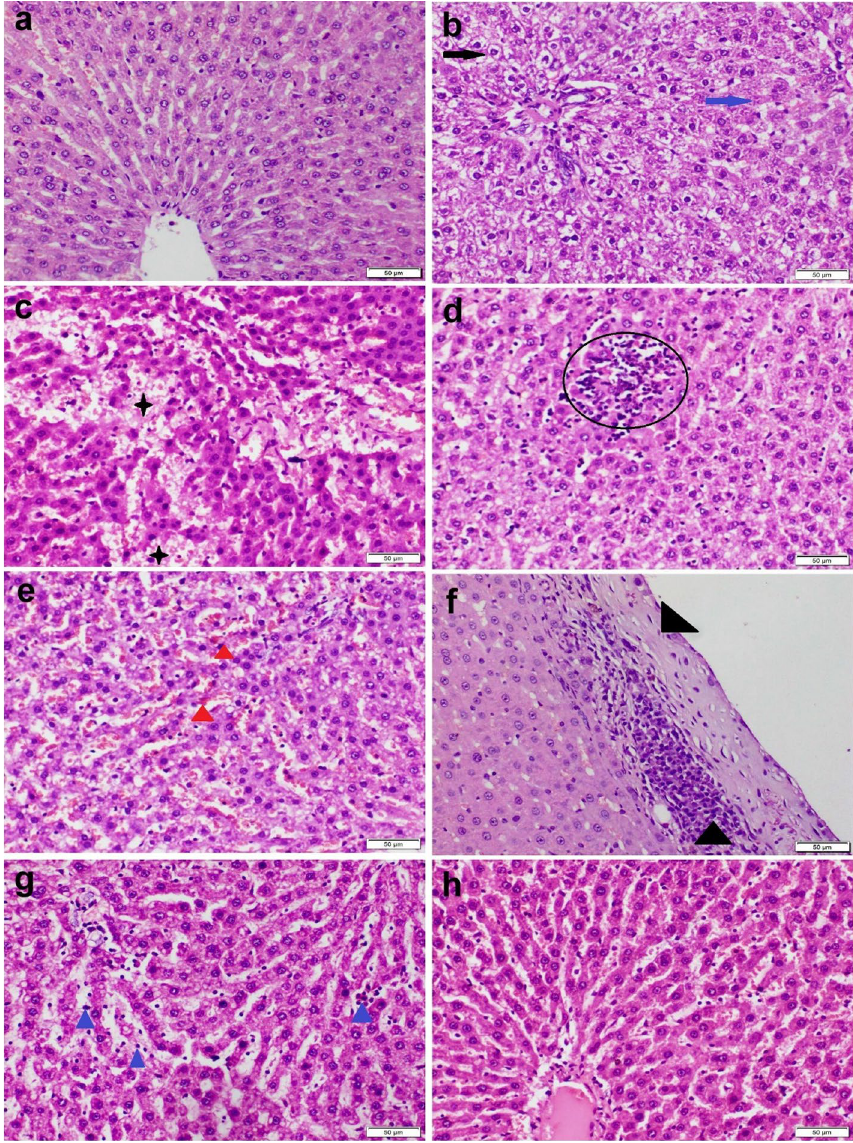
Figure 2. Photomicrograph of liver tissue sections stained by H&E representing; ( a ) Control group showing normal histological structure. ( b – f ) CBZ receiving group showing diffuse hepatocellular cytoplasmic vacuolization (black arrows) and sparse cell necrosis (blue arrows), hemorrhage (black stars), focal necrotic area with inflammatory cells infiltration (circle), sinusoidal congestion (red triangle), thickening of the Glissonian capsule with extensive inflammatory cells infiltration (black triangles). ( g – h ) CS-NPs + CBZ receiving group showing; ( g ) Sinusoidal lymphocytic exocytosis (blue triangle). ( h ) Normal histological